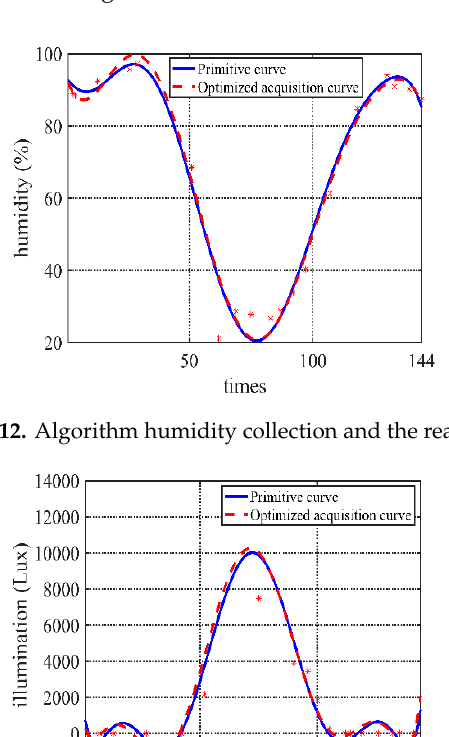
Figure 11. Convergence rate of adaptive genetic algorithm (AGA) and genetic algorithm (GA).